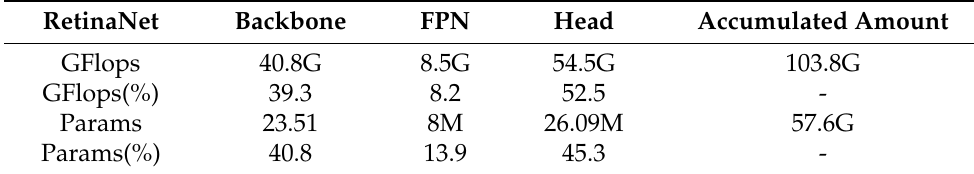
Table 2. Analysis of RetinaNet’s computation and parameter